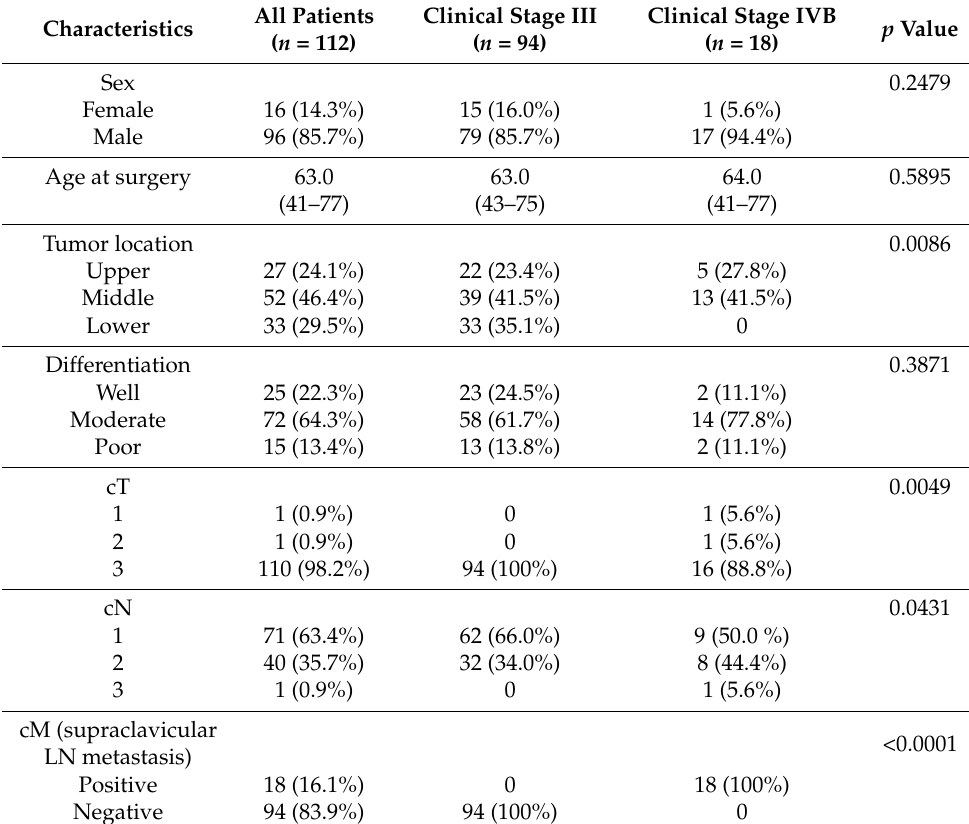
Table 1. Clinicopathological features of all 112 ESCC